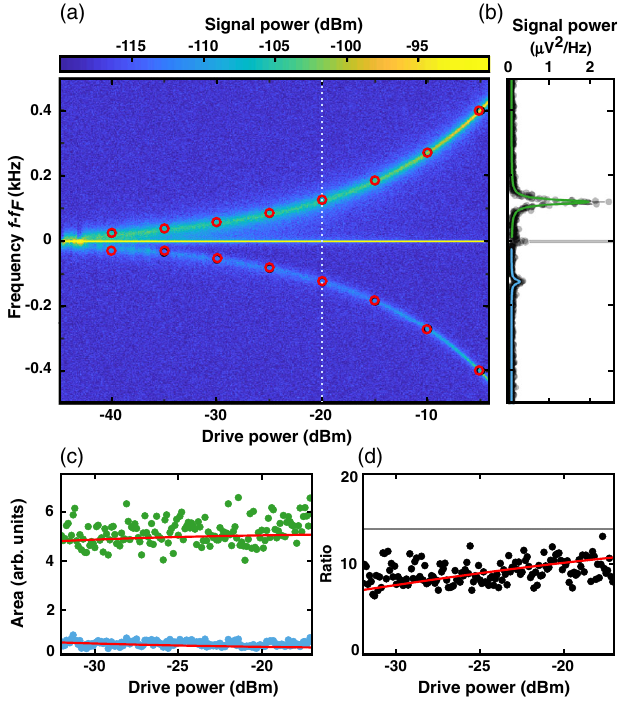
FIG. 2. (a) Color-coded power spectra showing the increasing splitting of the satellite peaks with the increasing drive power for the drive frequency f F ¼ f 0 , where the resonator is monostable. Red open circles denote the calculated positions of the satellite peaks. The central line at f − f F ¼ 0 is plotted with a reduced brightness to improve the visibility of the satellites. (b) Line cut along the white dotted line in (a) illustrating the satellite peaks as well as their Lorentzian fits for a drive of − 20 dBm. The central line at f ¼ f F (gray line) is truncated. (c) Area of the high- (green) and low- (blue) frequency satellite peaks extracted from the Lorentzian fits as a function of the drive power. Red lines show the theoretical prediction that takes into account the partial overlap of the peaks. (d) Ratio of the areas of the satellite peaks as a function of drive power. Red and gray lines show, respectively, the theoretical prediction that takes into account the partial overlap of the peaks (see SM [45]) and the one based on Eq.